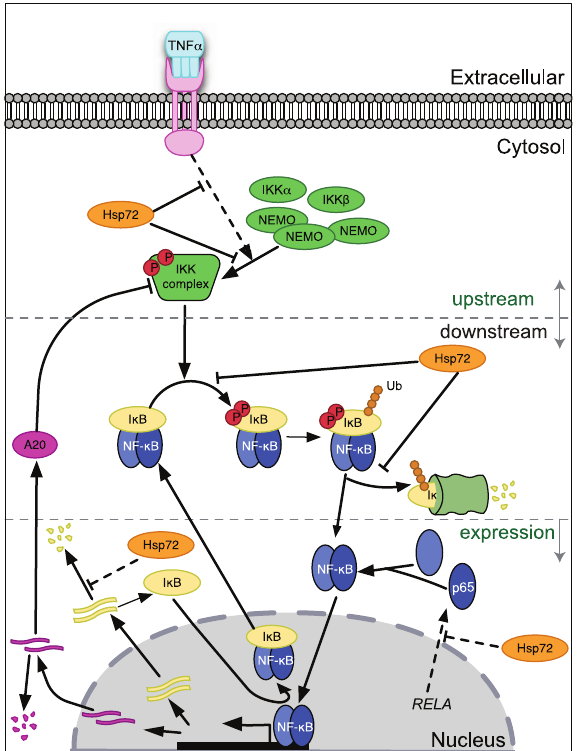
Figure 7. Updated mechanistic diagram for Hsp72 regulation of NF- k B signaling in microglia. Hsp72 regulation at the upstream level inhibiting IKK is an essential component in microglia, although the precise biomolecular mechanism cannot be discriminated. Hsp72 also plays a critical role in reducing synthesis of the p65 NF- k B subunit. Additionally, Hsp72 appears to increase the induction of I k B a transcript. Downstream of IKK, Hsp72 regulation may act to decrease phosphor- ylation and/or other steps in the stimulus-induced degradation of I k B a , though it appears less essential than the other two levels of regulation in this particular cell type and